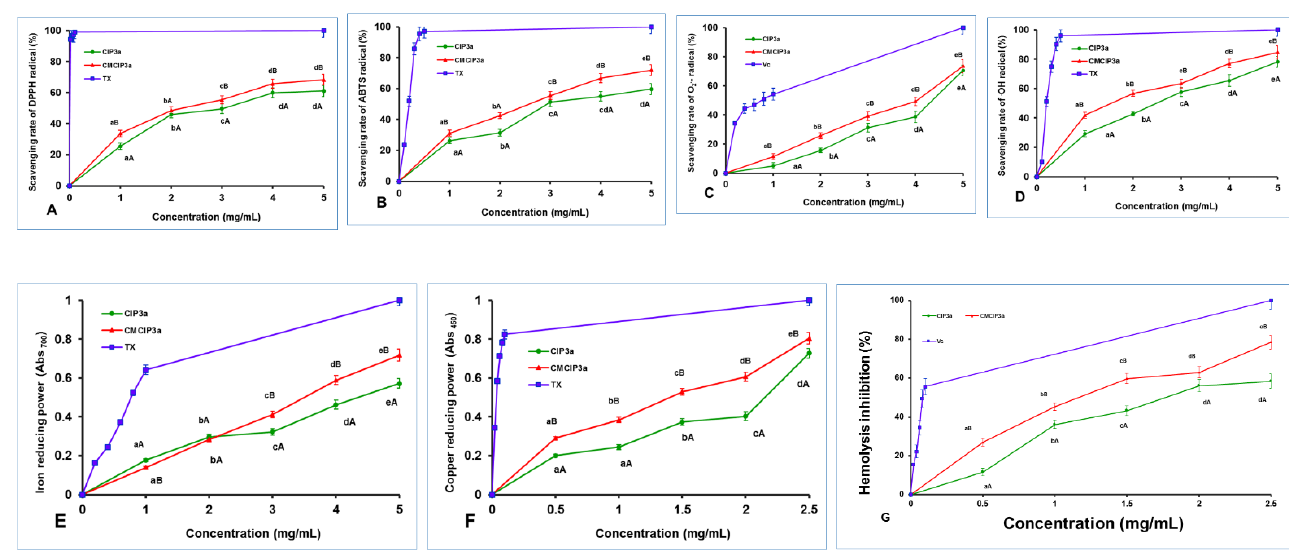
Figure 7. Antioxidant activity of CIP3a and CMCIP3a. ( A ) DPPH radical scavenging, ( B ) ABTS radical scavenging, ( C ) superoxide radical scavenging, ( D ) hydroxyl radical scavenging, ( E ) ferric ion reducing power, ( F ) cupric ion reducing power and ( G ) erythrocyte hemolysis inhibition. Data are the mean ± SD of three replicates, and small letters in superscripts (a–e) and capital letters (A,B) indicate significant differences ( p < 0.05) between concentrations of the same sample and different samples of the same concentration, respectively.